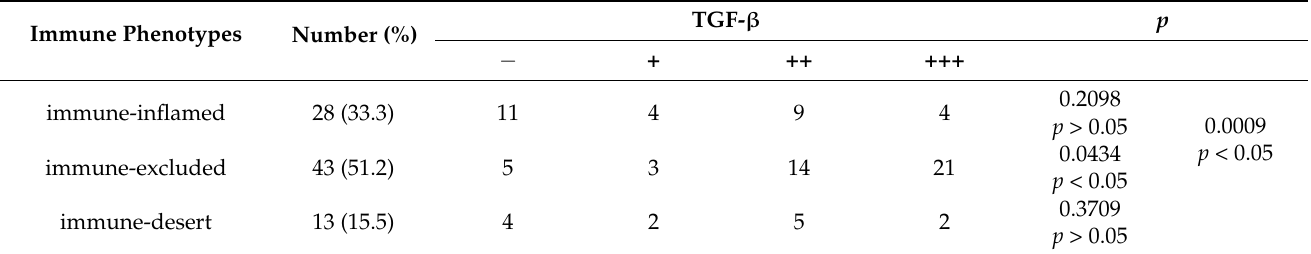
Figure 6. Representative images of CD8+ T cells and TGF- β 1 in the center of human gastric cancer tissues. Immune-inflamed phenotype, CD8+ T cells were mainly located in the tumor and the paracancerous stroma; immune-excluded, CD8+ T cells are mainly located in the paracancerous stroma; immune-desert, CD8+ T cells were not overtly seen in the tumor or paracarcinoma (TGF- β 1, Transforming Growth Factor- β 1). Table 4. Correlation between TGF-β and cancer-immune phenotypes in gastric cancer tissues (n).